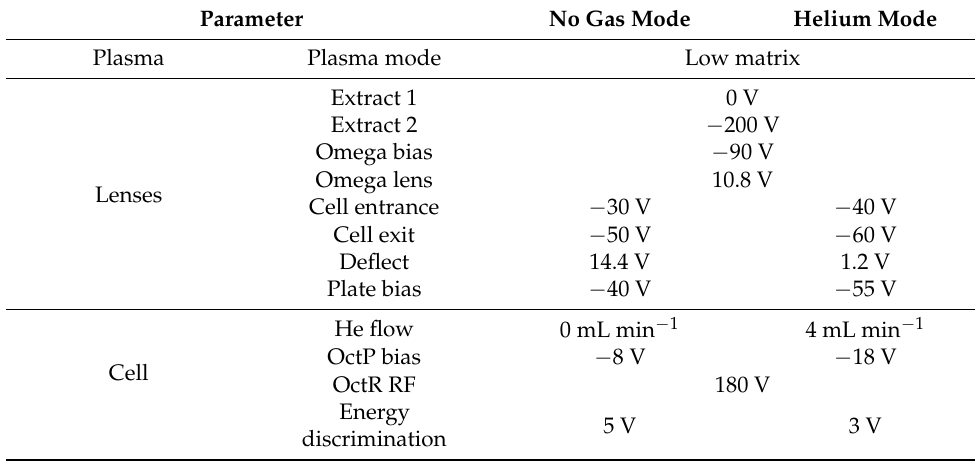
Table 3. ICP-MS operating parameters for the detection of